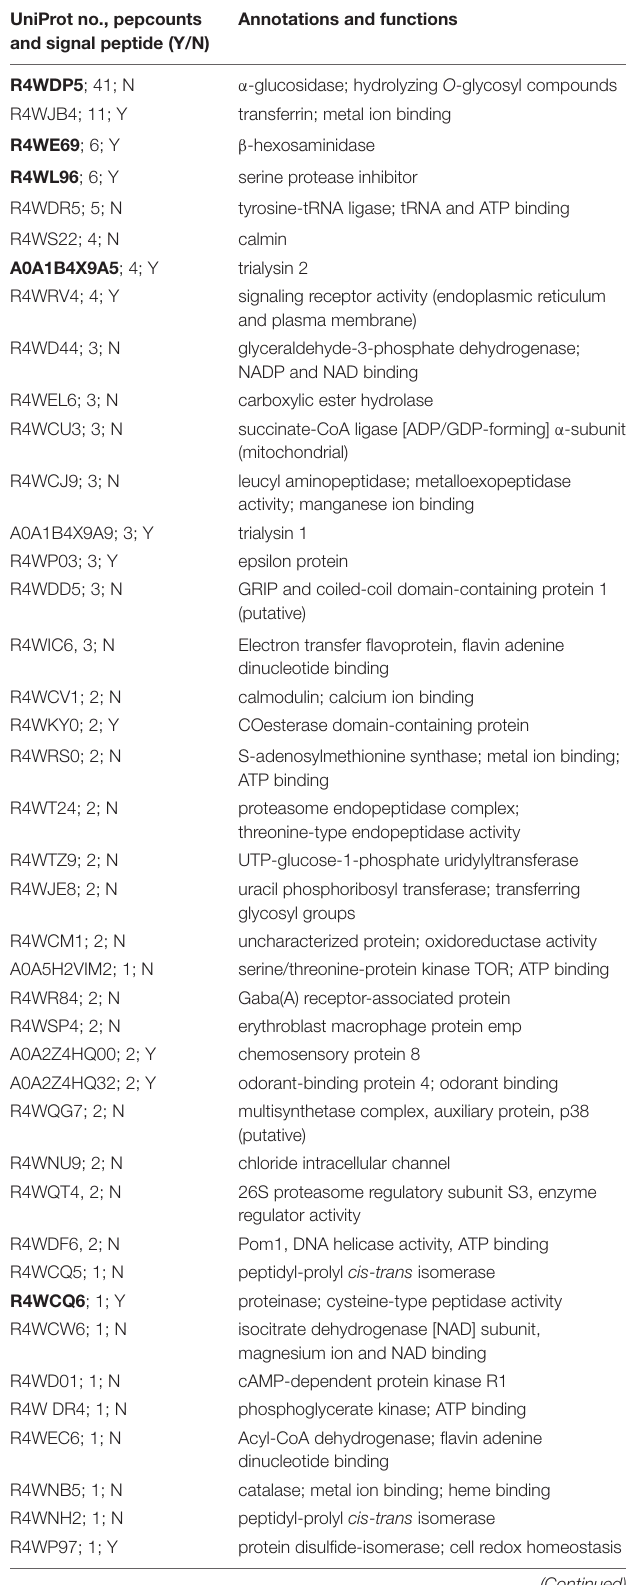
TABLE 2 | Salivary proteins of males identified by LC-MS/MS. UniProt no., pepcounts Annotations and and signal peptide (Y/N)